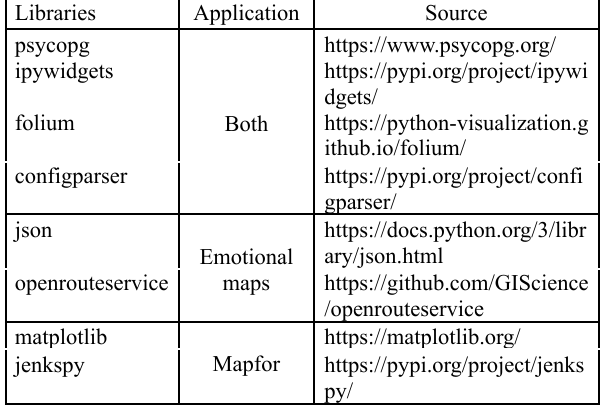
Table 1 . Libraries used in the development of the research and their